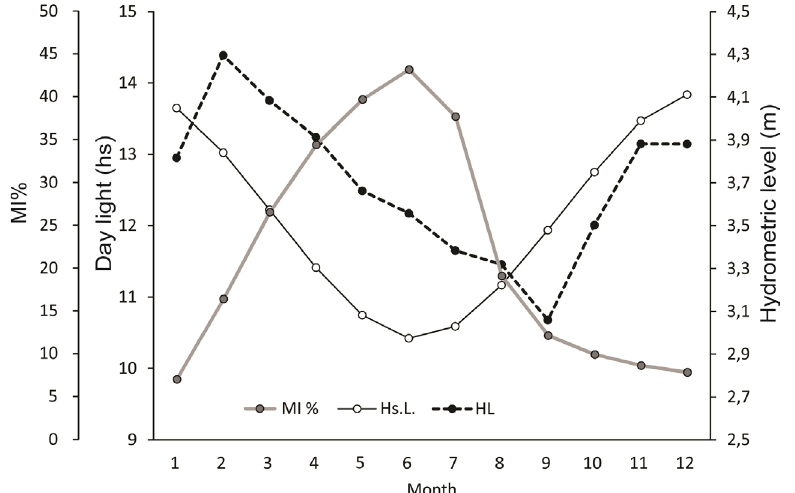
FIGURE 5 | Monthly averages of the percentage of marginal increase (MI%) in spines of Pseudoplatystoma corruscans , hours of day light (Hs.L.) and hydrometric levels of the Paraná River (HL) during the annual